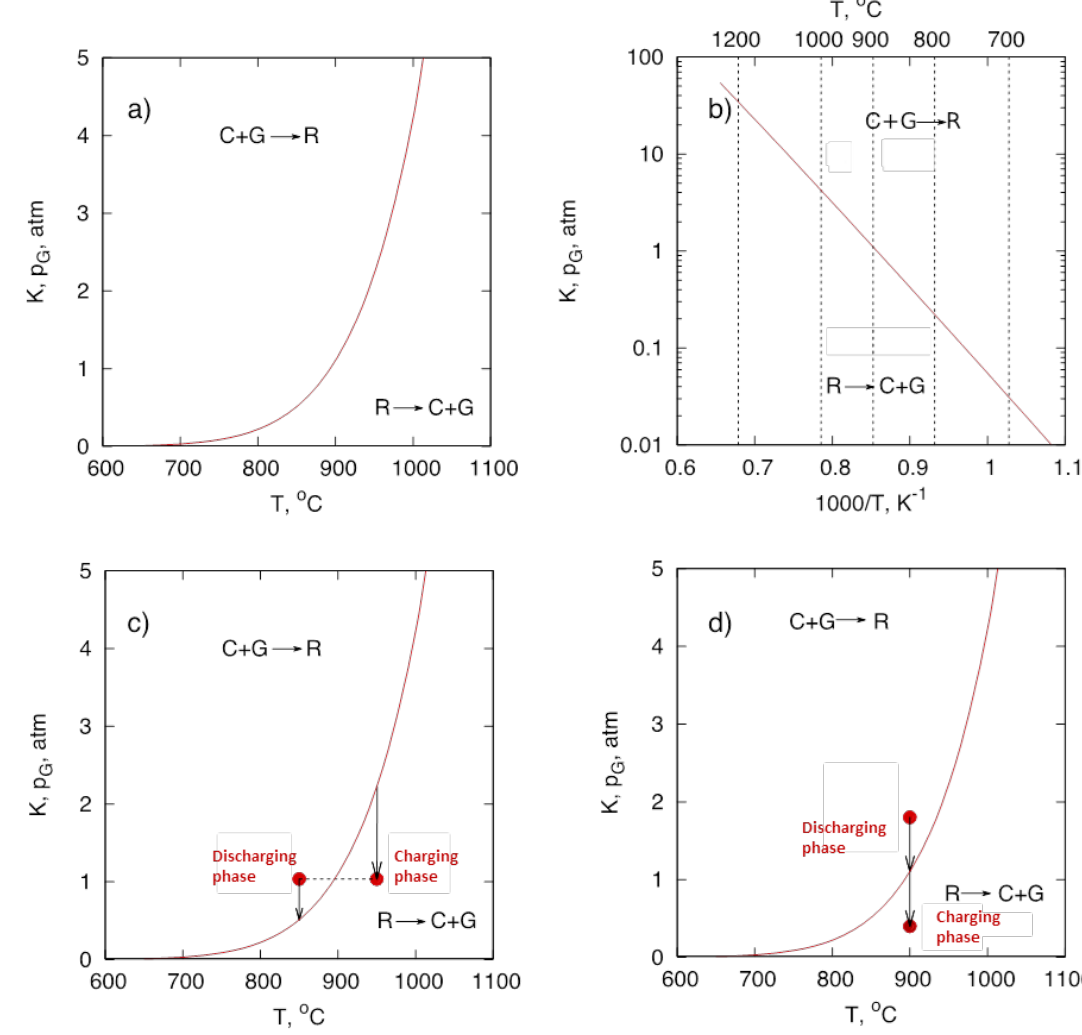
Figure 1. Thermodynamics of thermochemical storage for gas–solid systems: ( a ) P vs. T diagram; ( b ) P vs. 1/T diagram; ( c ) temperature swing mode; ( d ) pressure swing mode.